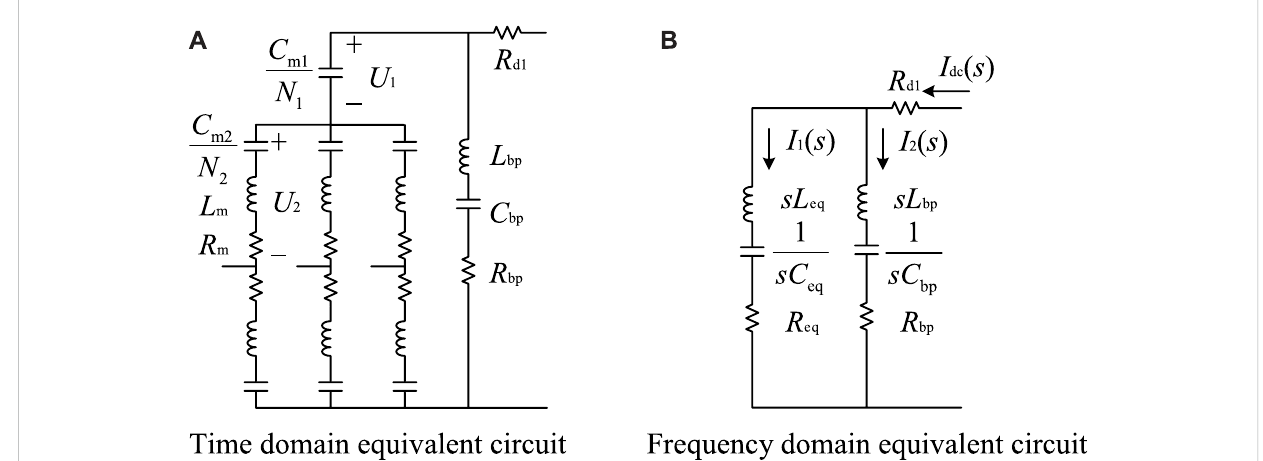
FIGURE 5 Equivalent circuits in uncontrollable precharging stage. (A) Time domain equivalent circuit. (B) Frequency domain equivalent